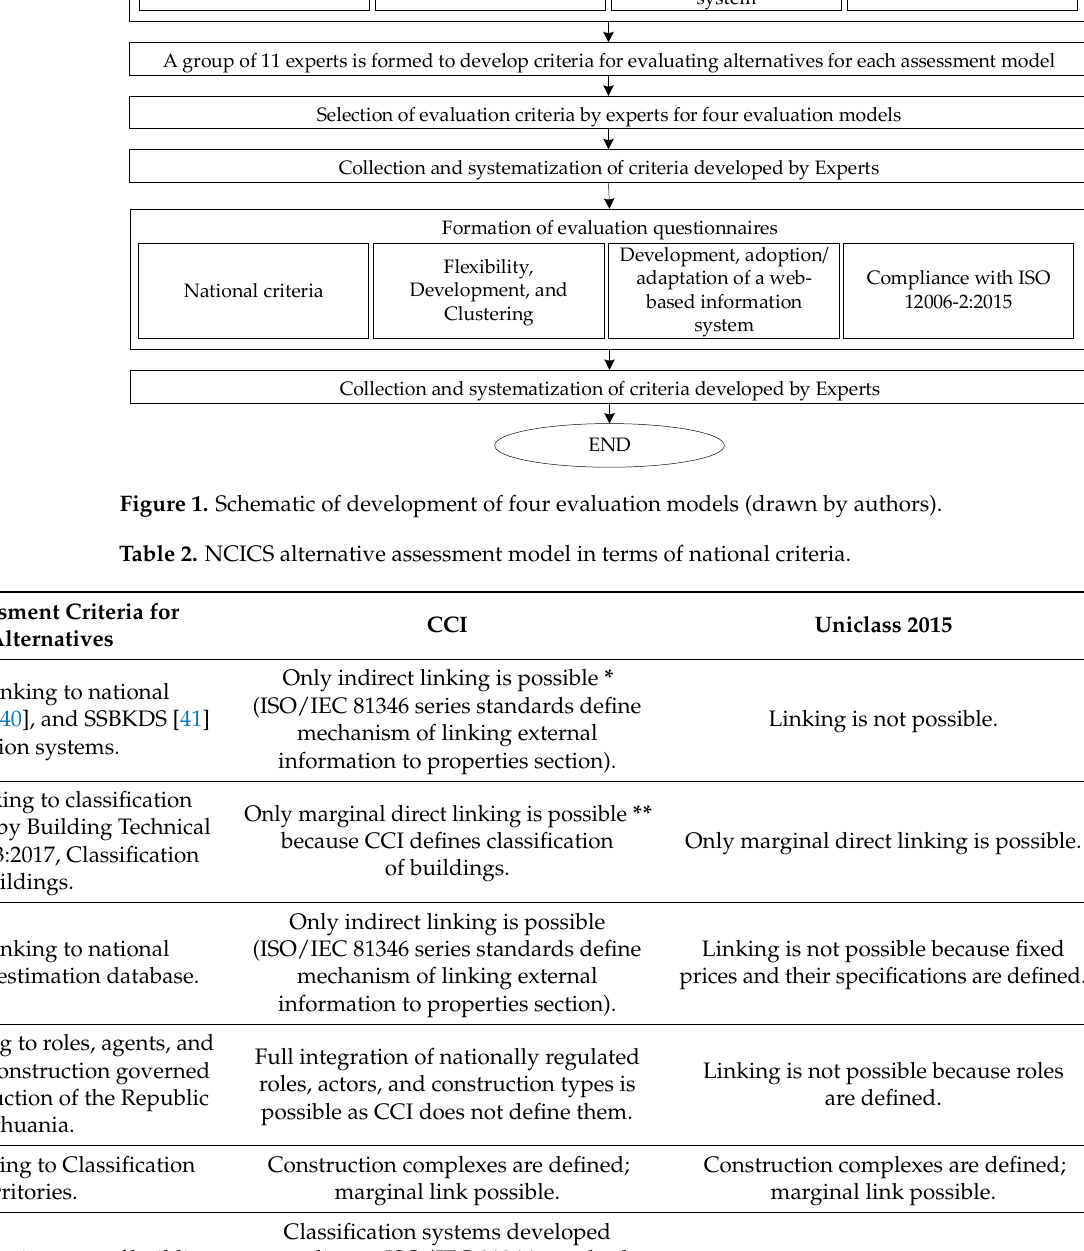
Table 2. NCICS alternative assessment model in terms of national criteria.